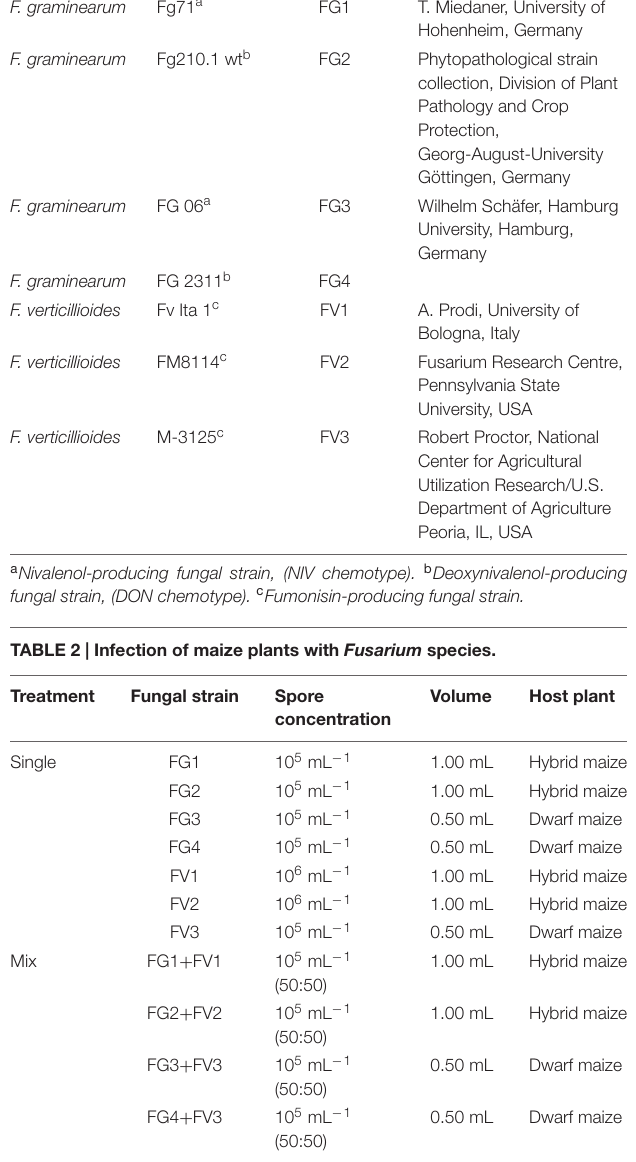
TABLE 1 | Fungal strains of Fusarium graminearum and F. verticillioides used in maize ear infections. Fungal strain